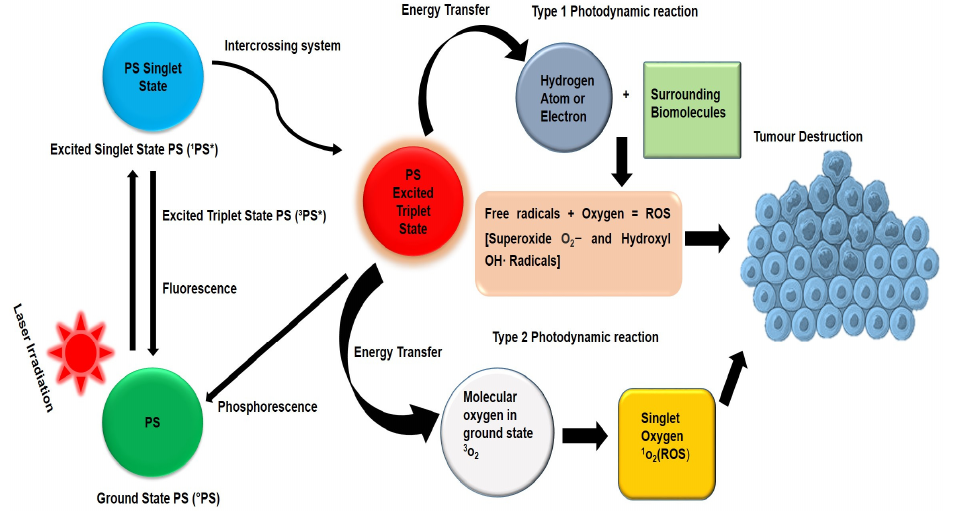
Figure 2. Photodynamic therapy mechanisms of action upon activation of a photosensitizer with a specific wavelength of light .